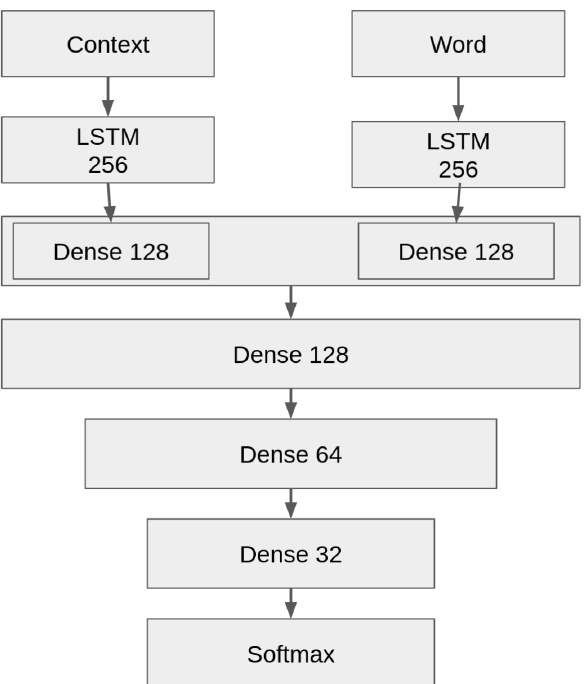
Figure 3. Deep Learning Architecture which is composed of two sets of input (context and a word) that feed into an uni-directional LSTM each. The rest of the architecture concatenates the LSTM layers and continues to merge dense layers with a softmax as the